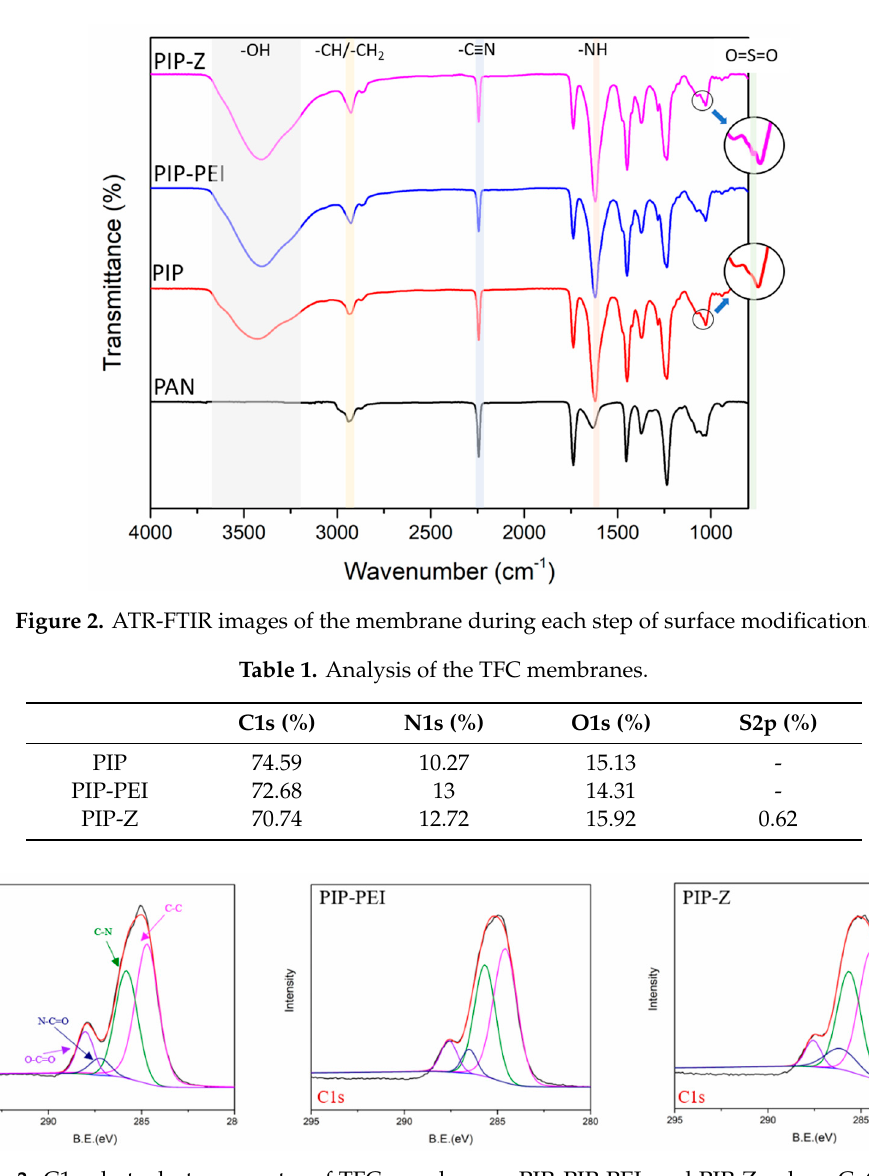
Figure 3. C1s photoelectron spectra of TFC membranes, PIP, PIP-PEI, and PIP-Z; where C–C, C–N, N–C=O, O–C=O peak at 284.6 eV, 285.6 eV, 287.5 eV, 288.5 eV, respectively. Table 2. Bond analysis of the TFC